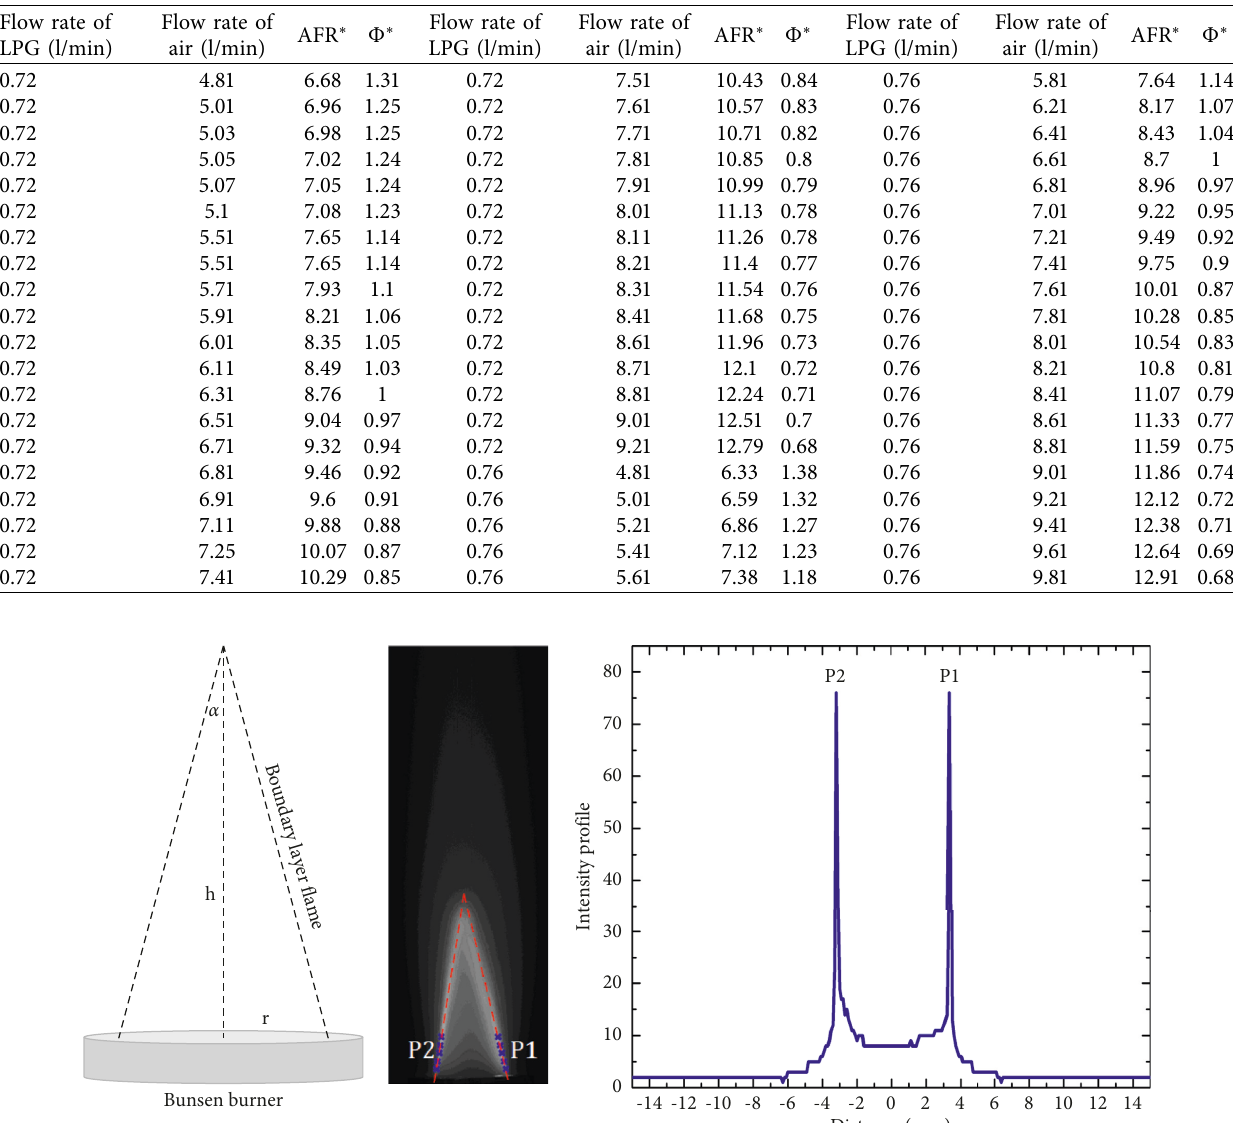
Table 2: The mixture of Saudi LPG/air for the modified Bunsen burner.